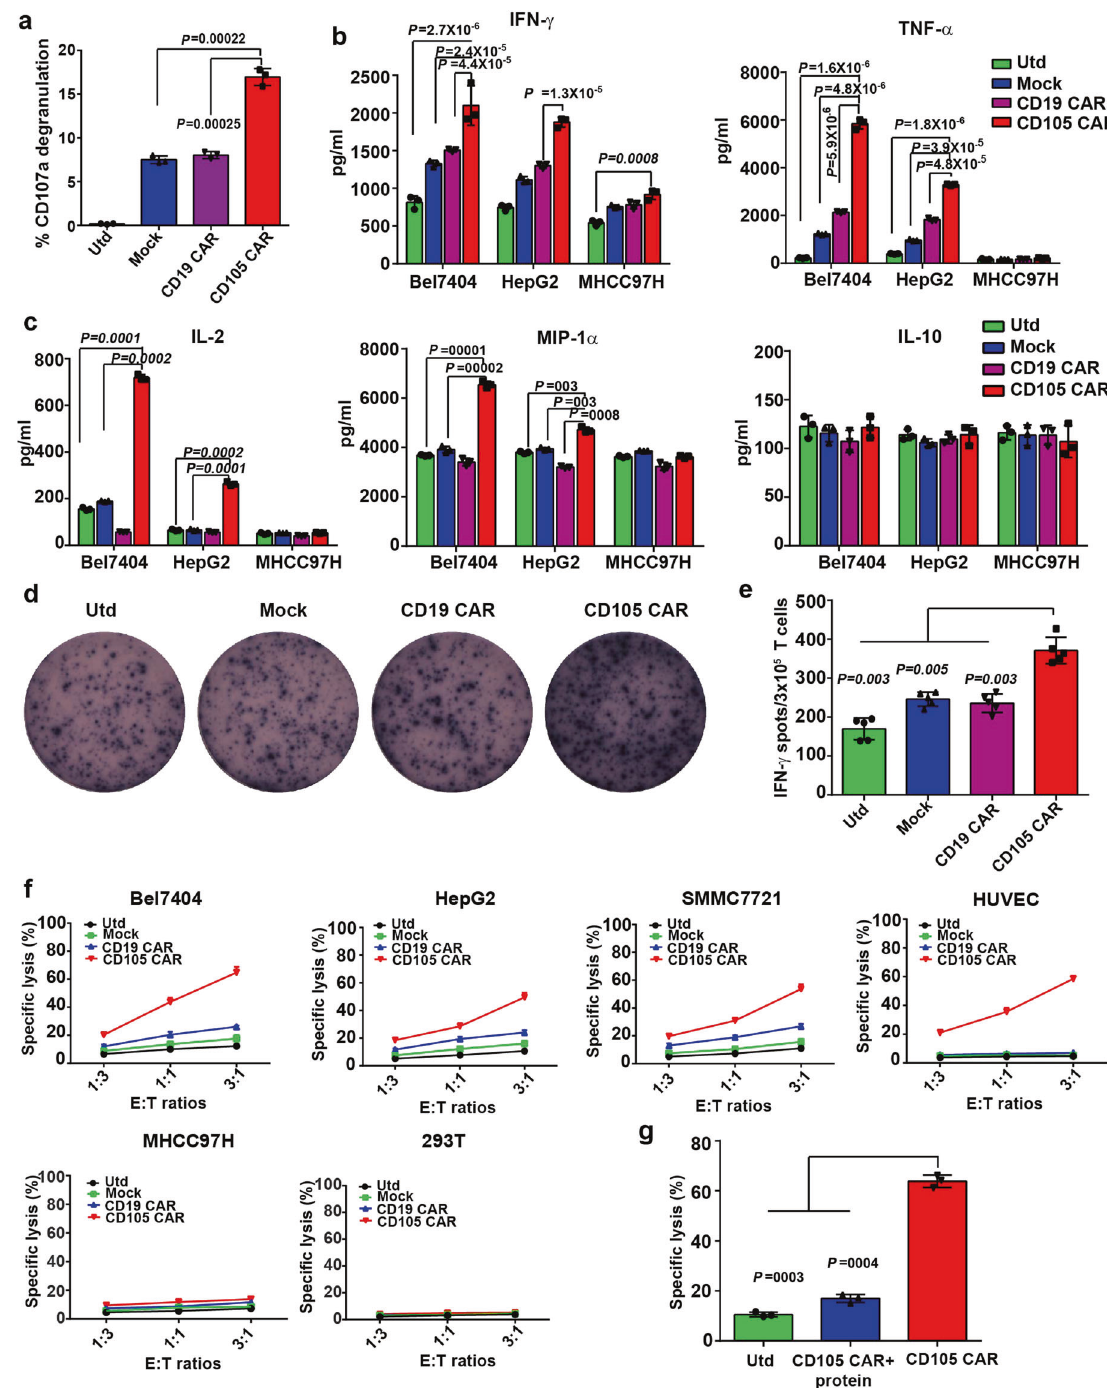
Fig. 4 Anti-CD105 CAR-T cells express CD107a, secrete positive regulatory cytokines, and ef fi ciently kill CD105-positive cells. a Anti-CD105 CAR-T cells undergo speci fi c degranulation to CD105 + cell. The anti-CD105 CAR, CD19 CAR, Mock, and Utd T cells were incubated with tumor cell for 12 h and CD107a degranulation was measured by fl ow cytometry. The percentages of CD107a + T cells of total anti-CD105 CAR-T cells were signi fi cantly higher than that of any other groups. b , c Anti-CD105 CAR-T cells produced higher levels of cytokines. CAR-T cells and Utd T cells were incubated with tumor cells for 12 h; the levels of cytokines in the culture supernatants were determined by ELISA assay. d , e ELISPOT analysis of the frequency of IFN- γ -secreted anti-CD105 CAR-T cells. f The anti-CD105 CAR-T cells were co-incubated with the indicated cells labeled with PKH26 at E/T ratio 1 : 3, 1 : 1, and 3 : 1 for 16 h and the ratios of PHK26 + PI + were measured by fl ow cytometry. Anti-CD105 CAR-T cells had potent cytotoxicity against CD105 + target cell and no cytotoxicity against CD105 − target cell. g CD105 CAR-T was incubated with CD105 protein for 30 min and then co-cultured with Bel7404 at an E/T ratio of 3 : 1 by fl ow cytometry assay. The results show that the killing effect of CD105 CAR-T on target cells is reduced after incubated with CD105 protein, indicating that CD105 CAR-T cells are targeted to CD105-positive cells. Data show the mean ± SD from three independent experiments. The quantitative analysis was used by one-way ANOVA with multiple comparisons test